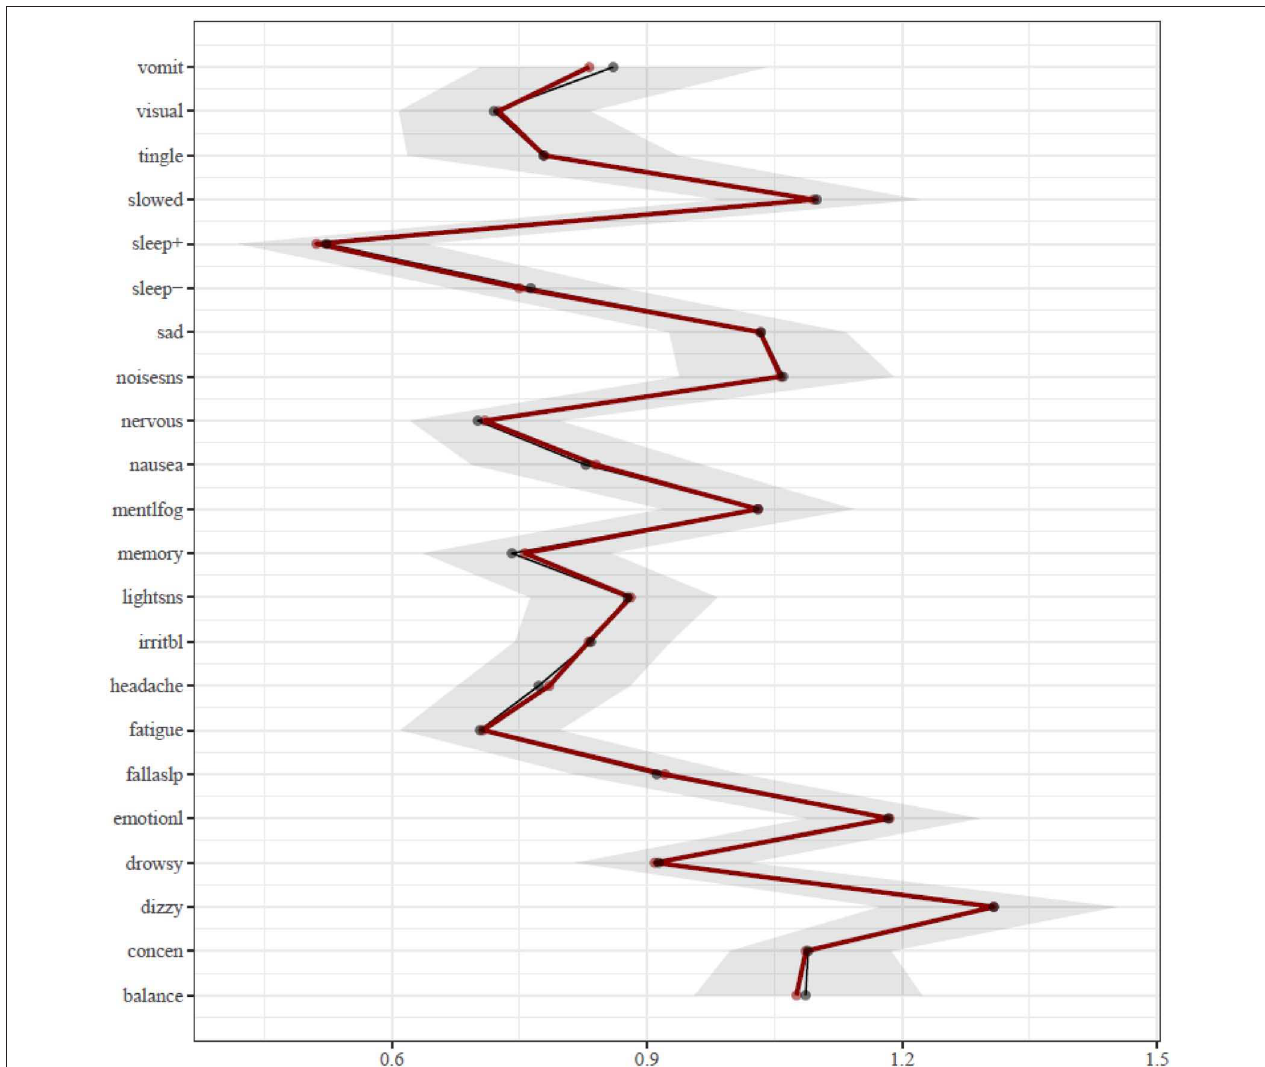
FIGURE 2 | Expected influence centrality estimates. The bootstrap means are presented in black and the sample means are presented in red. Symptoms: balance, balance problems; concen, difficulty concentrating; dizzy, dizziness; drowsy, drowsiness; emotionl, feeling more emotional; fallaslp, trouble falling asleep; fatigue, fatigue; headache, headache; irritbl, irritability; lightsns, light sensitivity; memory, difficulty remembering; mentlfog, mentally foggy; nausea, nausea; nervous, nervousness; noisesns, noise sensitivity; sad, sadness; sleep − , sleeping less than usual; sleep + , sleeping more than usual; slowed, feeling slowed down; tingle, numbness and tingling; visual, visual problems; vomit,